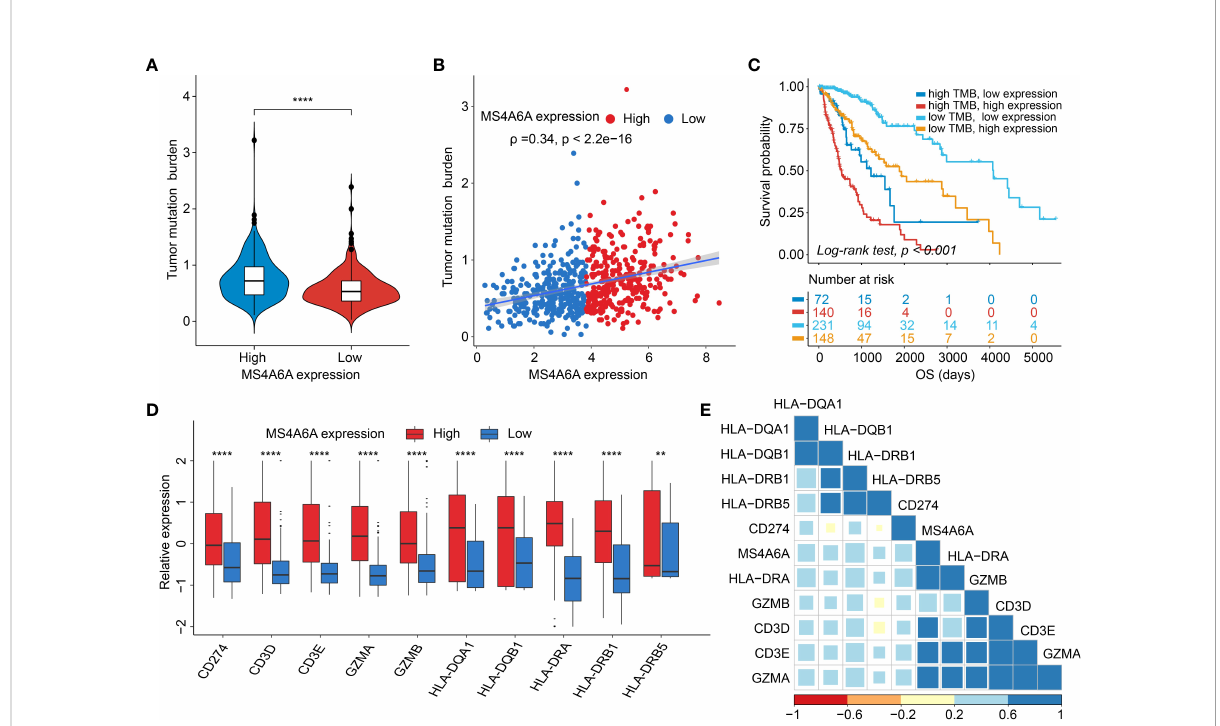
FIGURE 7 Correlation between the MS4A6A and immunotherapy-related markers.There were TMB differences after grouped by MS4A6A expression (A) . Dotplot of correlation of MS4A6A expression with TMB values (B) . Kaplan – Meier plot of gliomas OS in the TCGA set strati fi ed by TMB and MS4A6A (C) . Box plots of expression features of T cell-in fl amed markers between MS4A6A subgroups (D) . Corplot of correlation of MS4A6A expression with T cell-in fl amed signatures (E) (** p < 0.01; **** p <